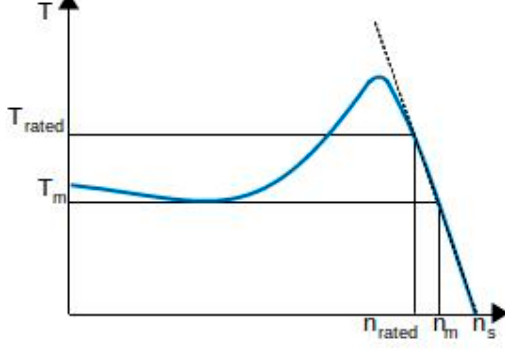
Figure 1. Torque versus speed curve linearization.